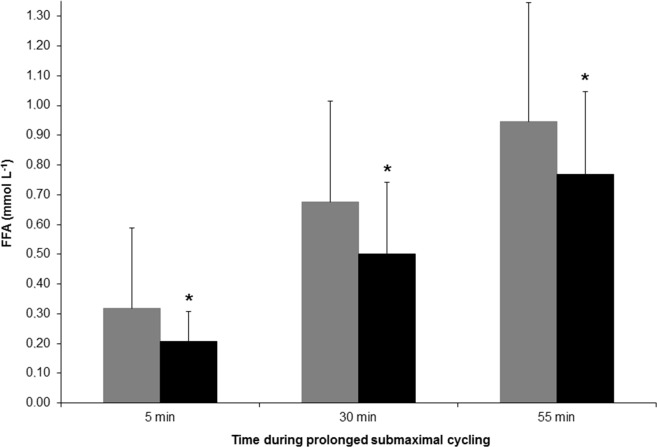
Plasma levels of free fatty acids (FFA) at three time points during the 60 min cycling exercise pre- (gray bars) and post- (black bars) snuff cessation (SC).